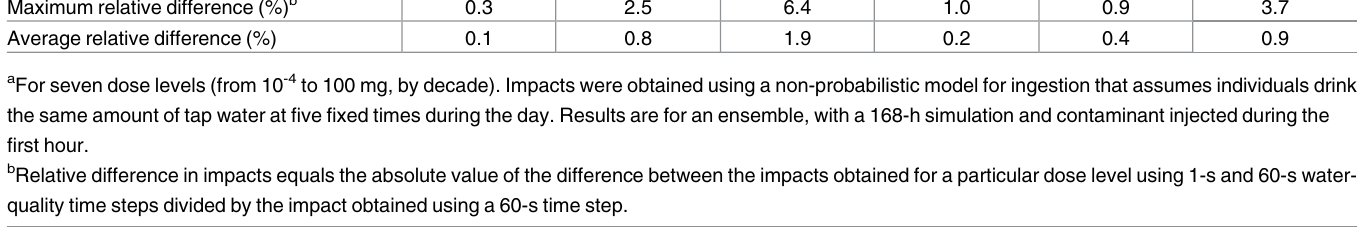
Table 9. Differencesin 95th and 100th Percentile Impacts Obtained with 60- and 1-s Water-quality Time Steps. a . Quantity